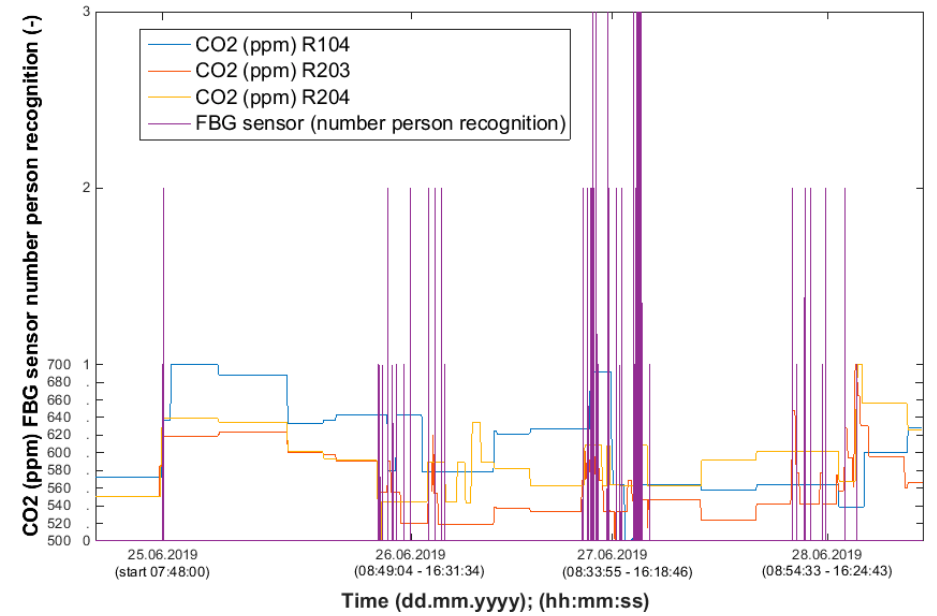
Figure 13. Waveforms of the CO 2 concentration values measured in SH rooms R104 (BT 12.09), R203 (BT 12.10), R204 (BT 12.11) in order to detect the occupancy of the monitored spaces with the representation of the recognition of the number of occupants in room R104 using the FBG sensor. Sensors 2020 , 20 , x FOR PEER REVIEW 14 of 29